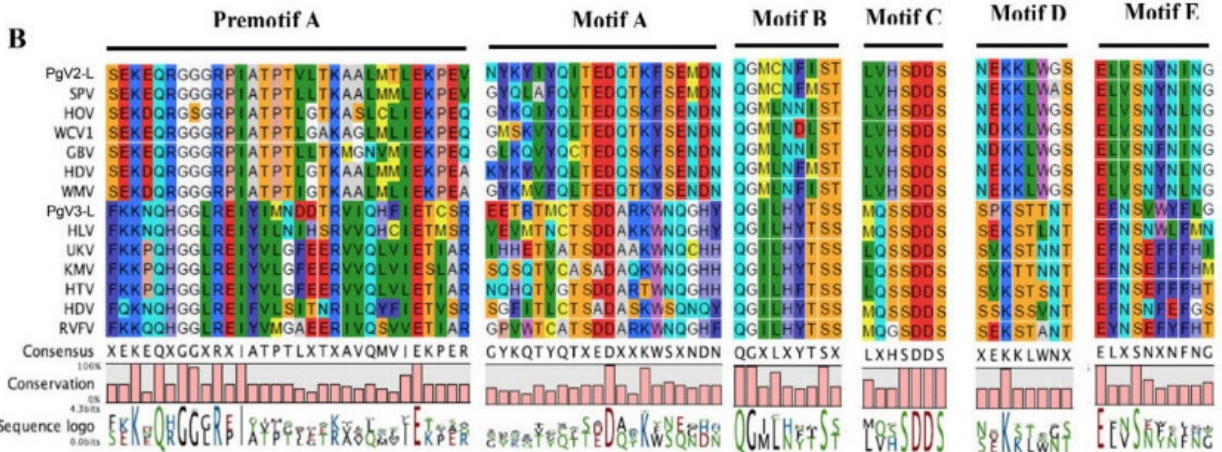
Figure 3. Genome organization and amino acid alignment of PecgV2 and PecgV3. ( A ): CDD and InterProScan analysis of genome structure of PecgV2 (top) and PecgV3 (below). ( B ): Amino acid alignment between conserved RdRp premotif A and motifs A–E of PecgV2 and PecgV3, and selected ( − ss)RNA viruses. The accession numbers of sequences for amino acid alignment are listed in File S1; red bars represent the conserved motifs in the genome.